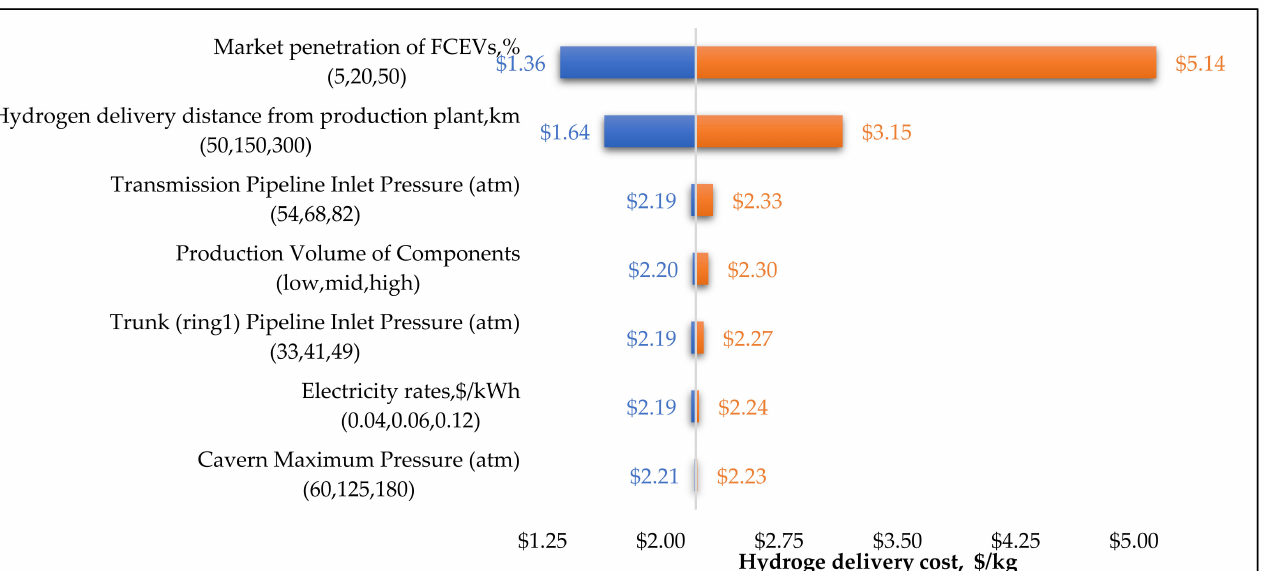
Figure 11. Range of hydrogen production costs for a 5 tpd forecourt SMR plant. Figures 12–14 represent the sensitivity analysis for hydrogen delivery to a 1.5 tpd refueling station using three different modes: pipelines, gaseous tube trailer and liquid tanker. The costs are generated using the HDSAM model.